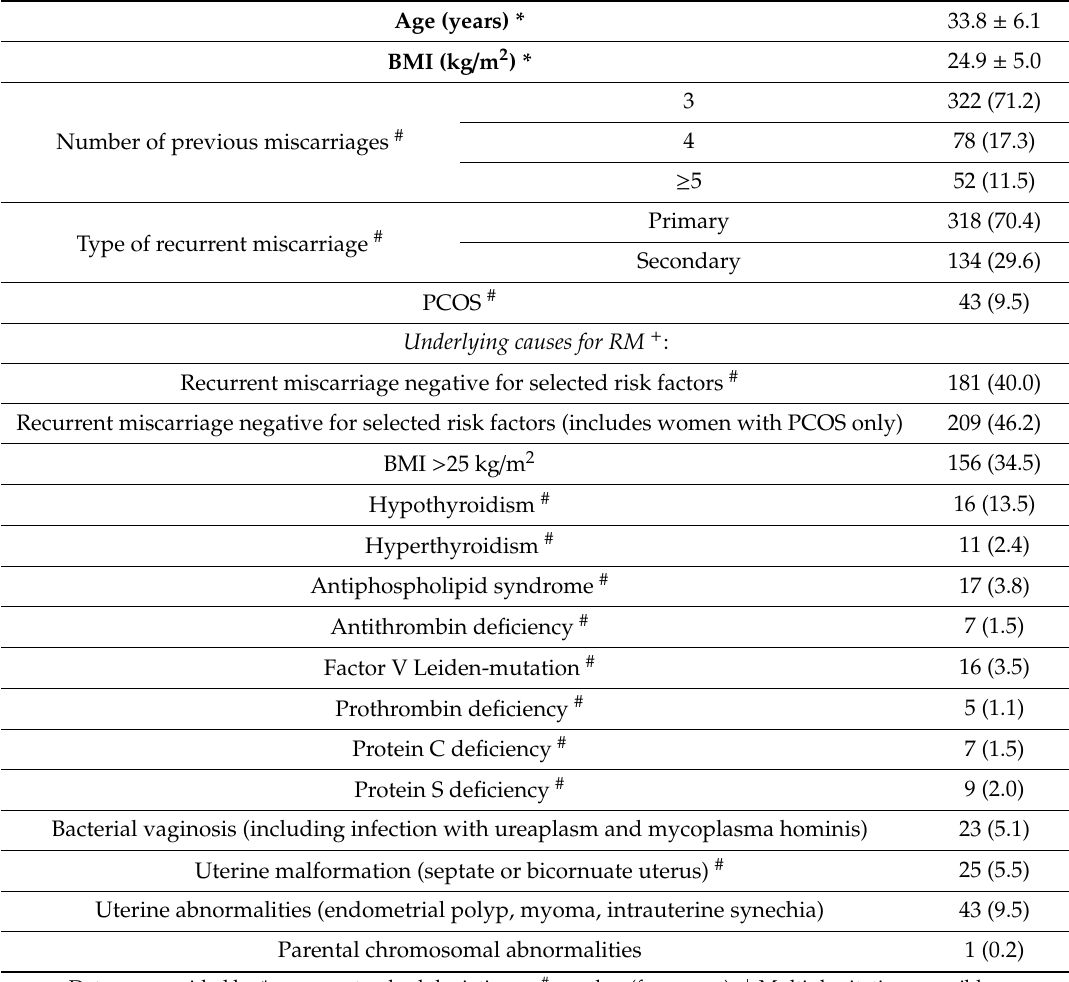
Table 1. Basic patient characteristics and results of complete evaluation of RM in the retrospective cohort ( n =